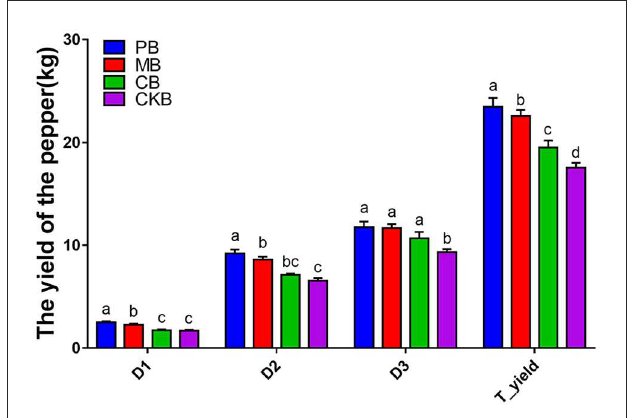
FIGURE1 The total pepper yield and yield at different time points. a–d indicate the statistical diferences at P < 0.05 for one-way ANOVA.